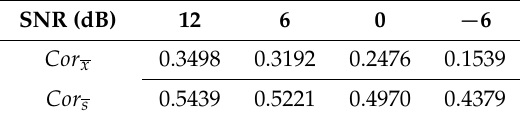
Table 6. Cor for MA under different SNR